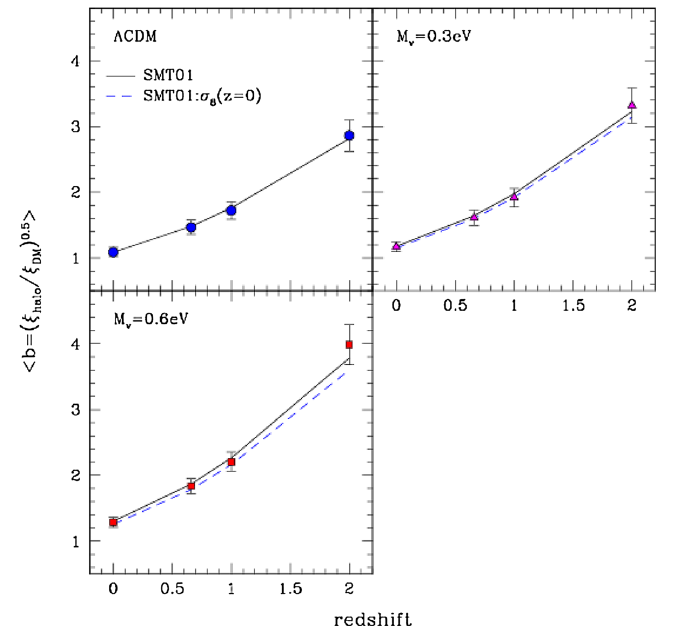
Fig.46 Meanbias(averagedin10 < r [ Mpc / h ] < 50)asafunctionofredshiftcomparedwiththetheoret- icalpredictionsofShethandTormen(2002).Herethedashedlinesrepresentthetheoreticalexpectationsfor a Λ CDM cosmology renormalized with the σ 8 value of the simulations with a massive neutrino component